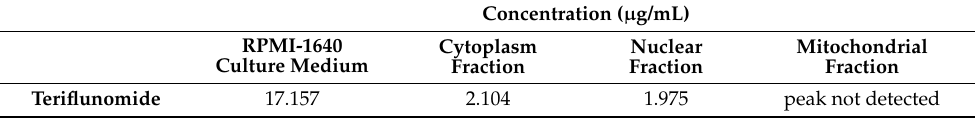
Table 1. Concentration of teriflunomide (A771726) in each cell fraction and culture medium.